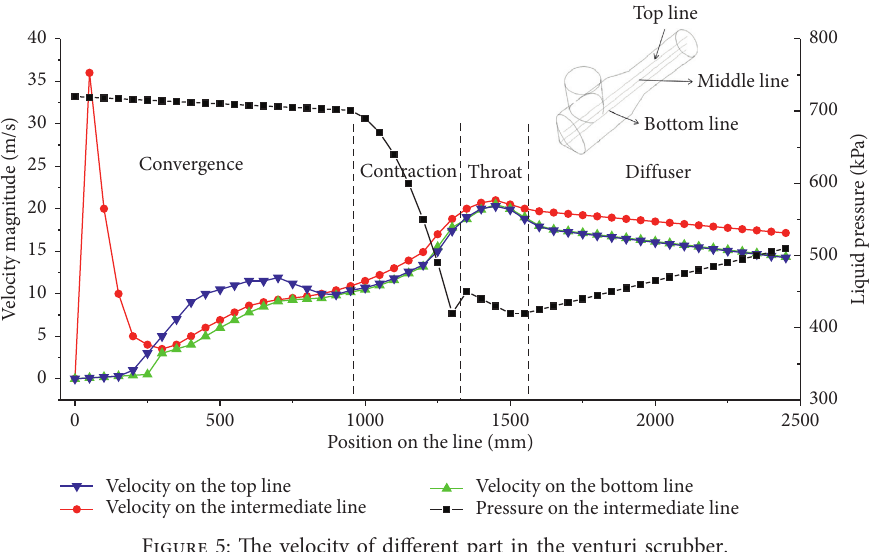
Velocity on the bottom line Pressure on the intermediate line Figure 5: The velocity of different part in the venturi scrubber.